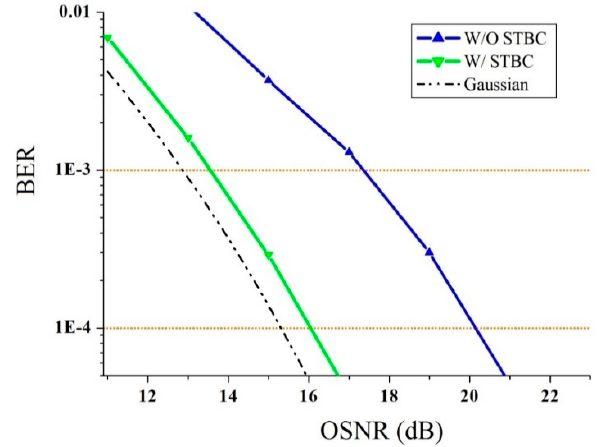
Figure 17. The BER vs. OSNR comparison for PDM-16QAM signal in LP 11a mode with or without using the STBC-RLS scheme [31].